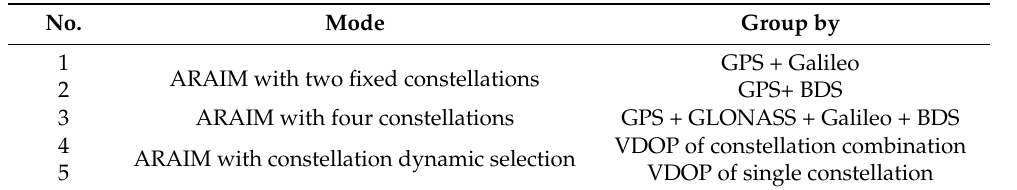
Table 2. ARAIM modes and groups.